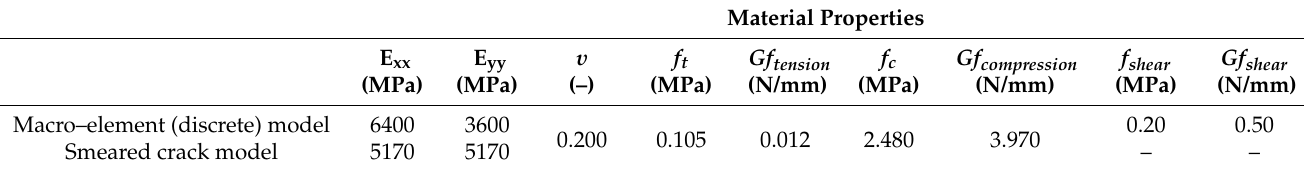
Table 4. Material properties adopted for the LNEC brick house benchmark performance